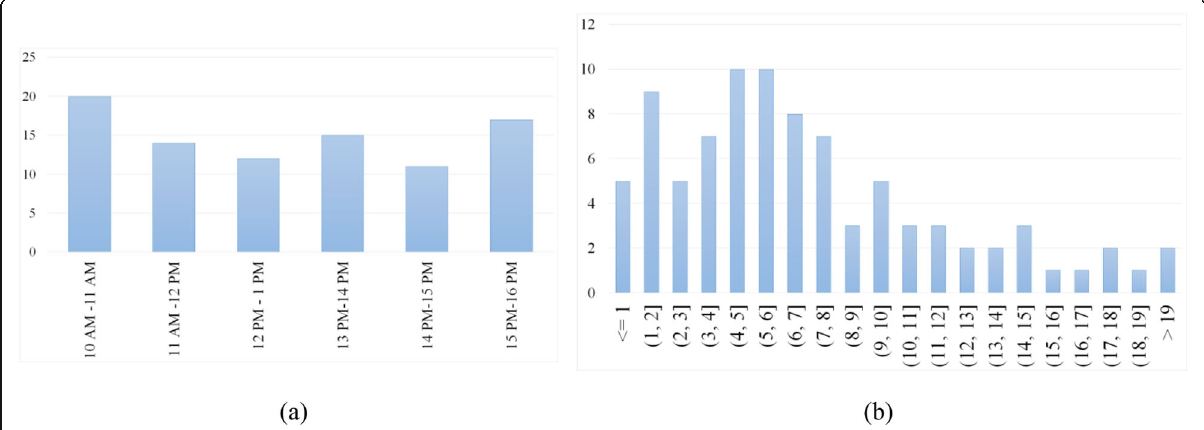
Fig. 5 Distribution of stops events recorded in hour intervals ( a ) and distribution of stop events duration in minutes intervals ( b